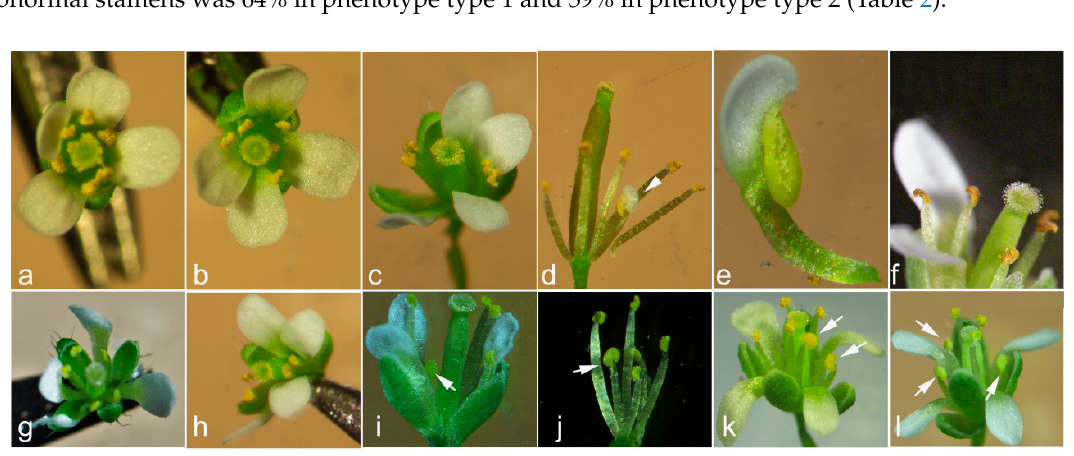
Figure 5. Phenotypic effects of CpCZF1 and CpCZF2 on transgenic Arabidopsis. ( a ) A WT flower with four long medial stamens and two short lateral stamens; ( b – f ) Flowers of 35S:CpCZF1 plants; ( b ) Flower with one lateral stamen lost; ( c ) Flower with both lateral stamens lost. ( d ) Flower with one lateral stamen changed to a partial petaloid; ( e ) An enlargement of a partial petaliod stamen; ( f ) Flower with anthers withered before the pistil could be fertilized; ( g – l ) Flowers of the 35S:CpCZF2 plants; ( g ) Flower with one lateral stamen lost; ( h ) Flower with both lateral stamens lost; ( i ) Flower with one staminode and one lateral stamen lost; ( j ) Flower with one staminode; ( k ) Flower with two staminodes; ( l ) Flower with three staminodes. Arrowhead indicates a partial petaloid stamen; arrows indicate the staminodes. To enhance the observations, the sepals and petals in photo ( d ), the sepals, petals, and carpels in photo ( j ) that were normal were all removed. Table 1. Phenotypical characterization of flower morphology in 35S:CpCZF1 and 35S:CpCZF2 transgenic Arabidopsis.